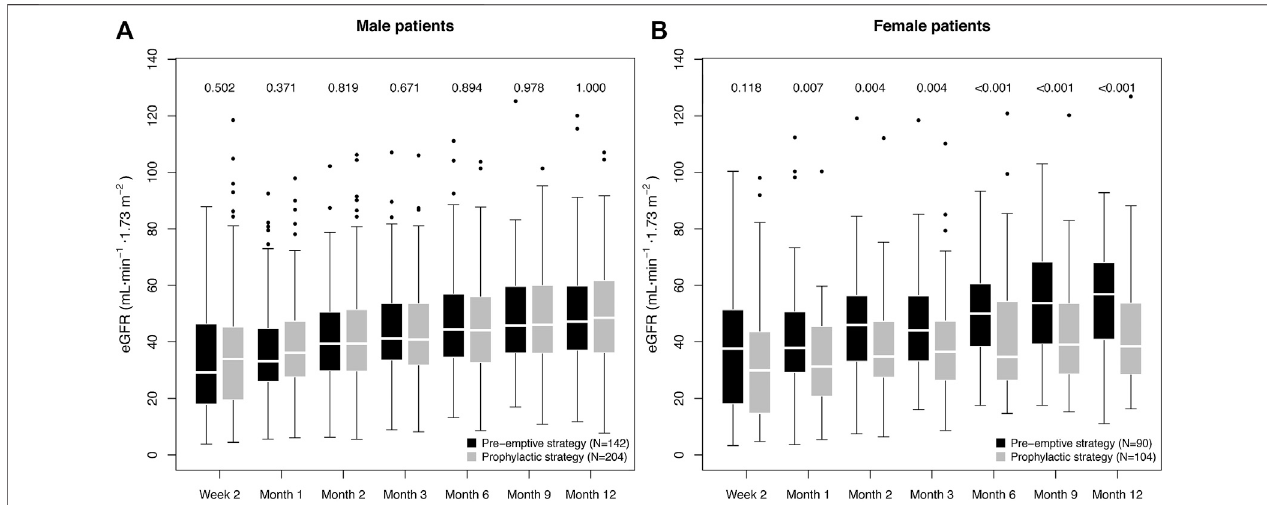
FIGURE 1 | Box plot of the graft function dynamics of the prevention strategy groups strati fi ed for sex. The numbers indicate the p value of the difference in eGFR between the prevention strategy groups, as calculated using the Mann-Whitney test. The p values for the fi rst six measurements are included only to facilitate understanding on the eGFR dynamics, and are therefore not adjusted for multiple